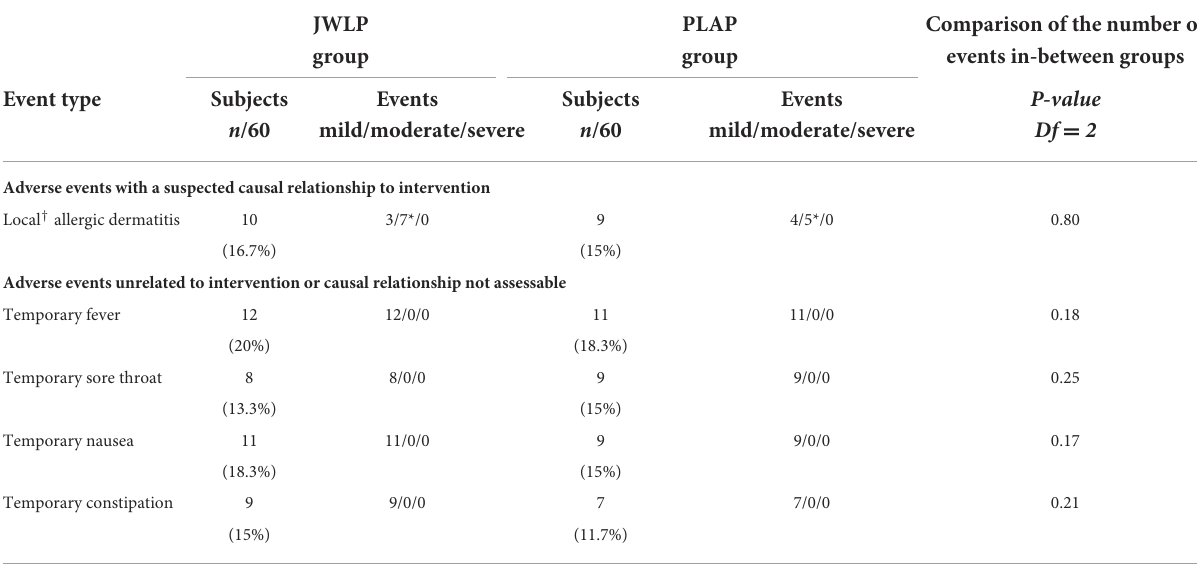
TABLE 4 Adverse events by MedDRA preferred terms and by treatment